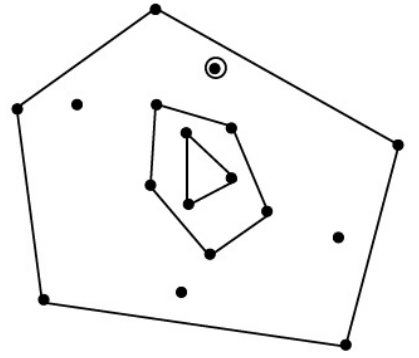
Figure 21: Deletion of a